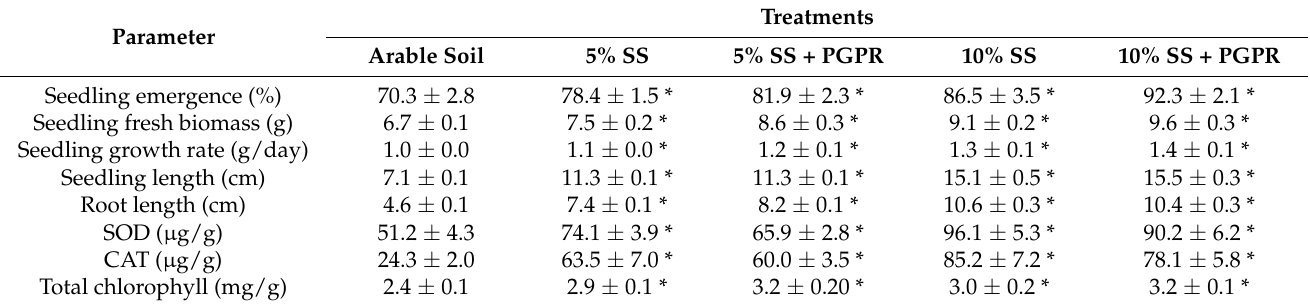
Table 3. Effect (mean ± standard deviation, n = 3) of sewage sludge (SS) and plant growth-promoting rhizobia (PGPR) treatment on germination and biochemical response of Ridge gourd ( L. acutangula ) seedlings (25 ◦ C for 7 days).